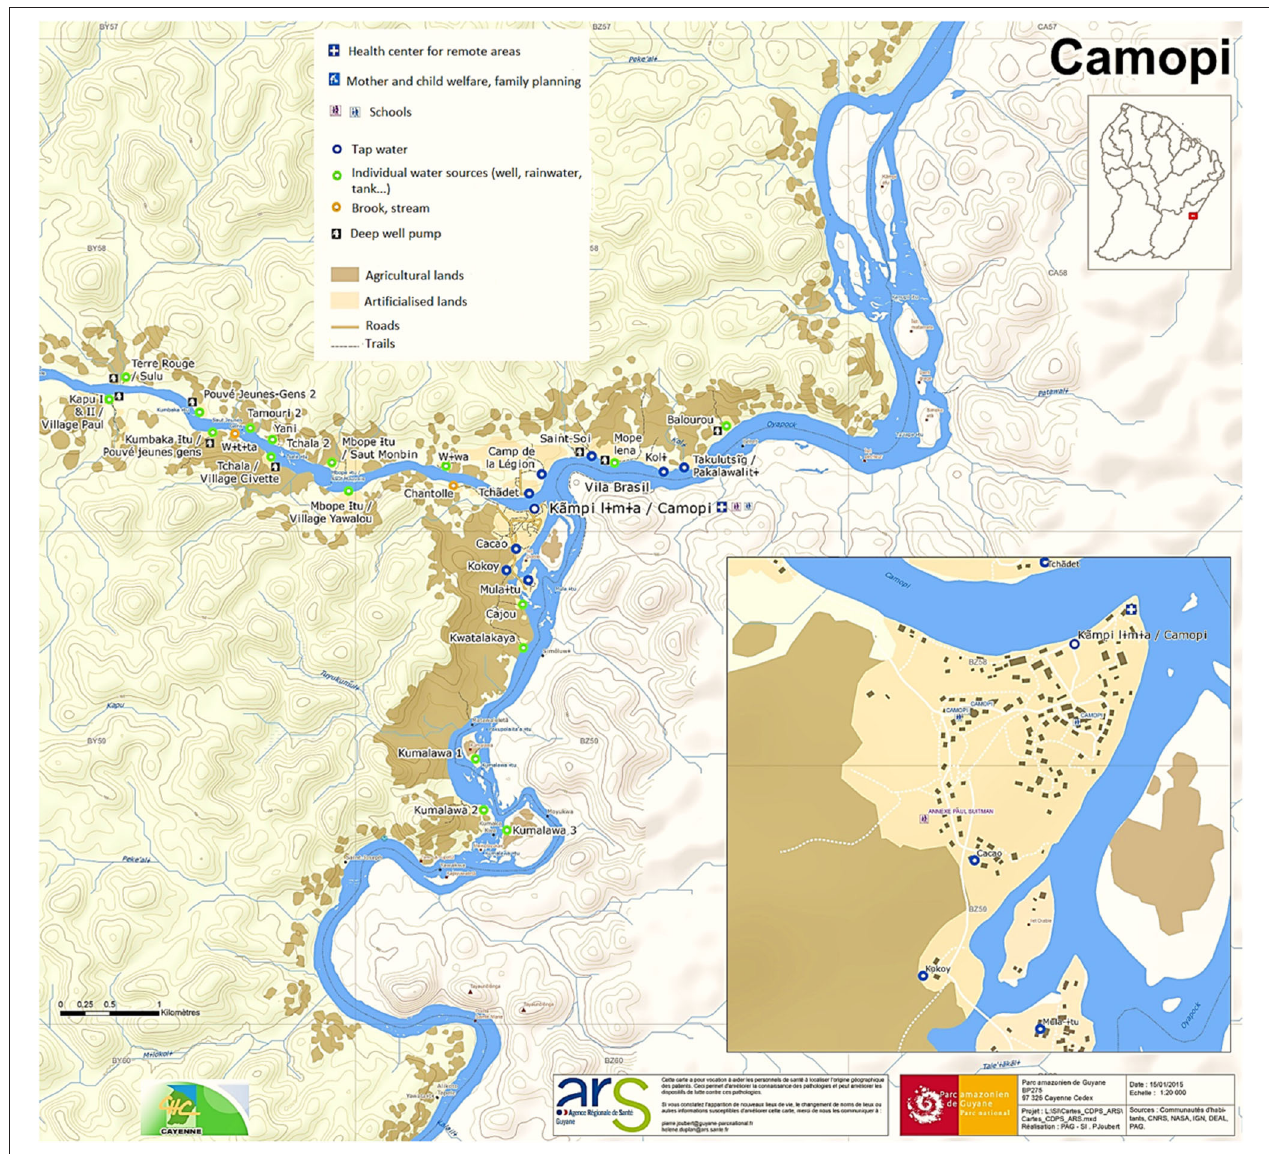
FIGURE 1 | Map of the village of Camopi, provided by the Guiana Amazonian Park (Parc Amazonien de